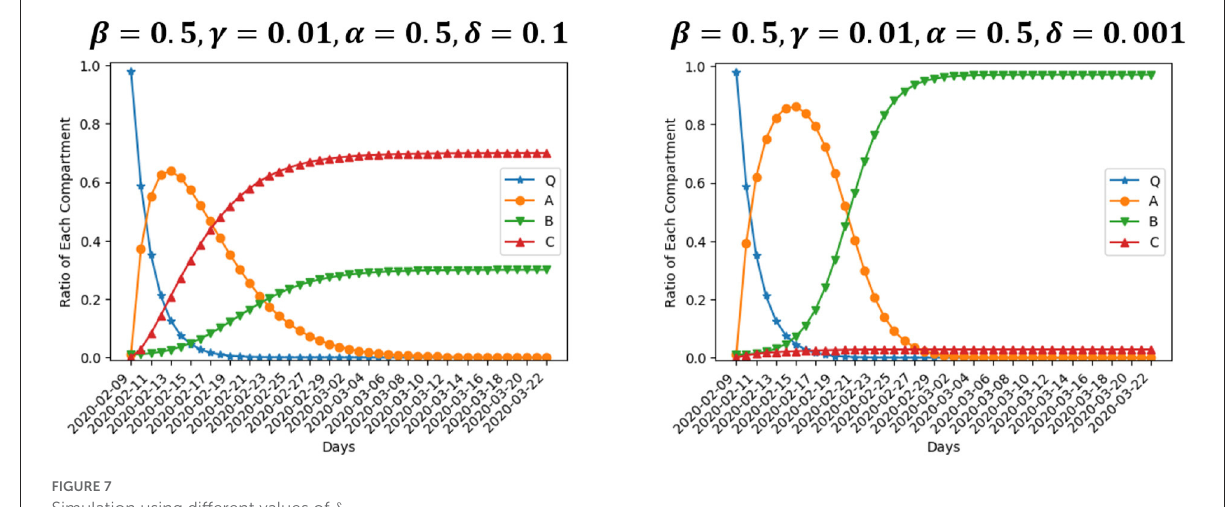
FIGURE7 Simulation using different values of δ